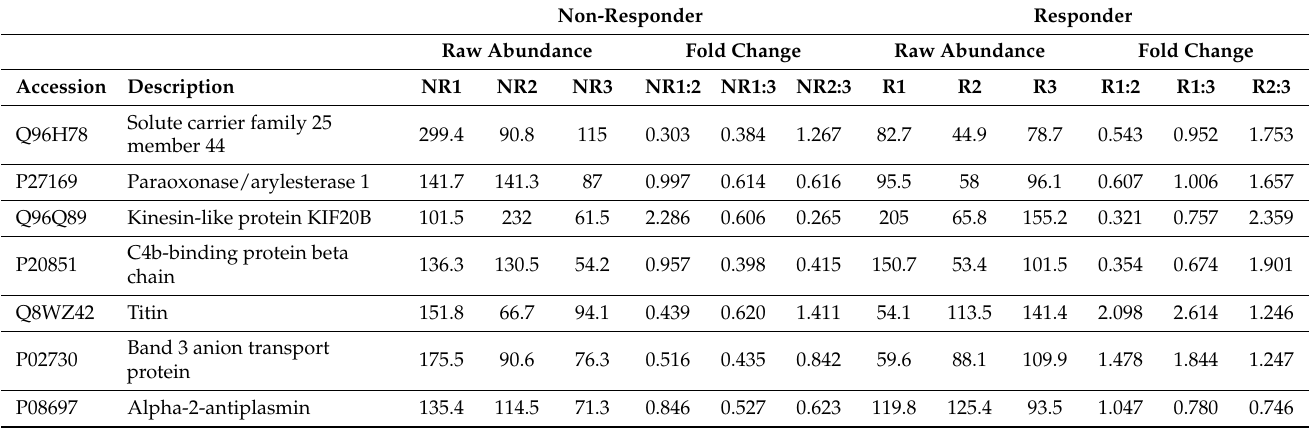
Table 4. Extracellular vesical associated proteins that are decreased in abundance in the non-responder. Non-Responder